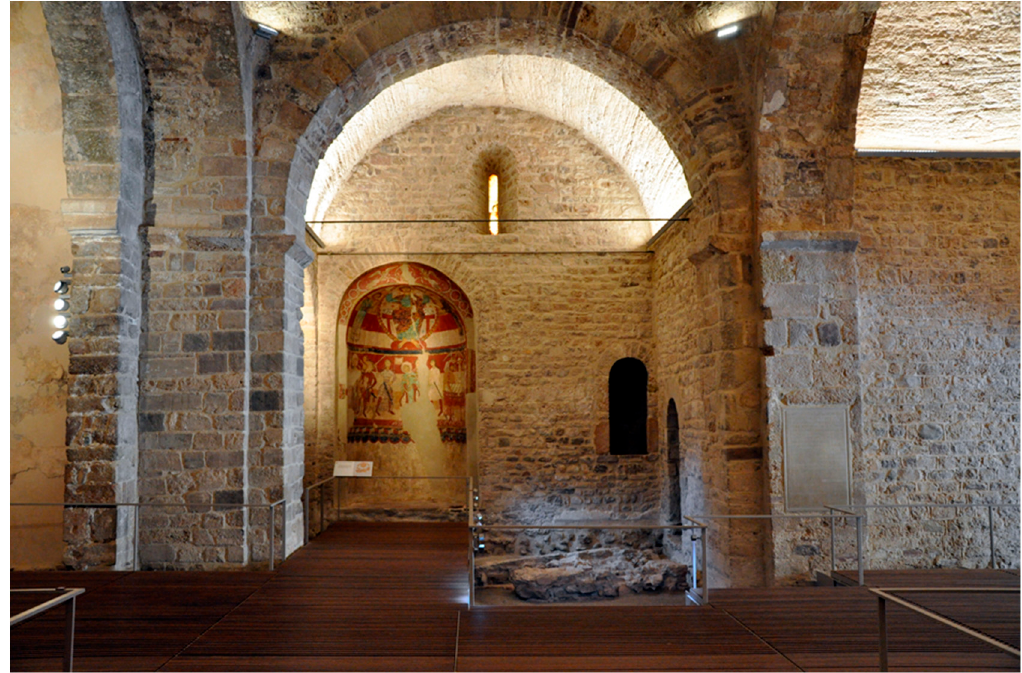
Figure 10. Church of Santa Maria de Terrassa. Thomas Becket chapel. © Photo: Carles Sánchez.